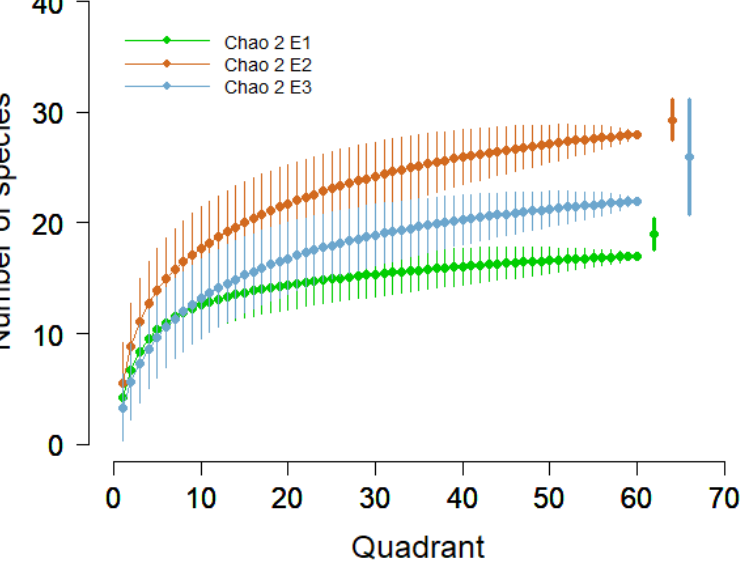
Figure 3. Accumulation curves with 95% confidence intervals and Chao 2 estimator (points on the right of the figure) for three elevations.